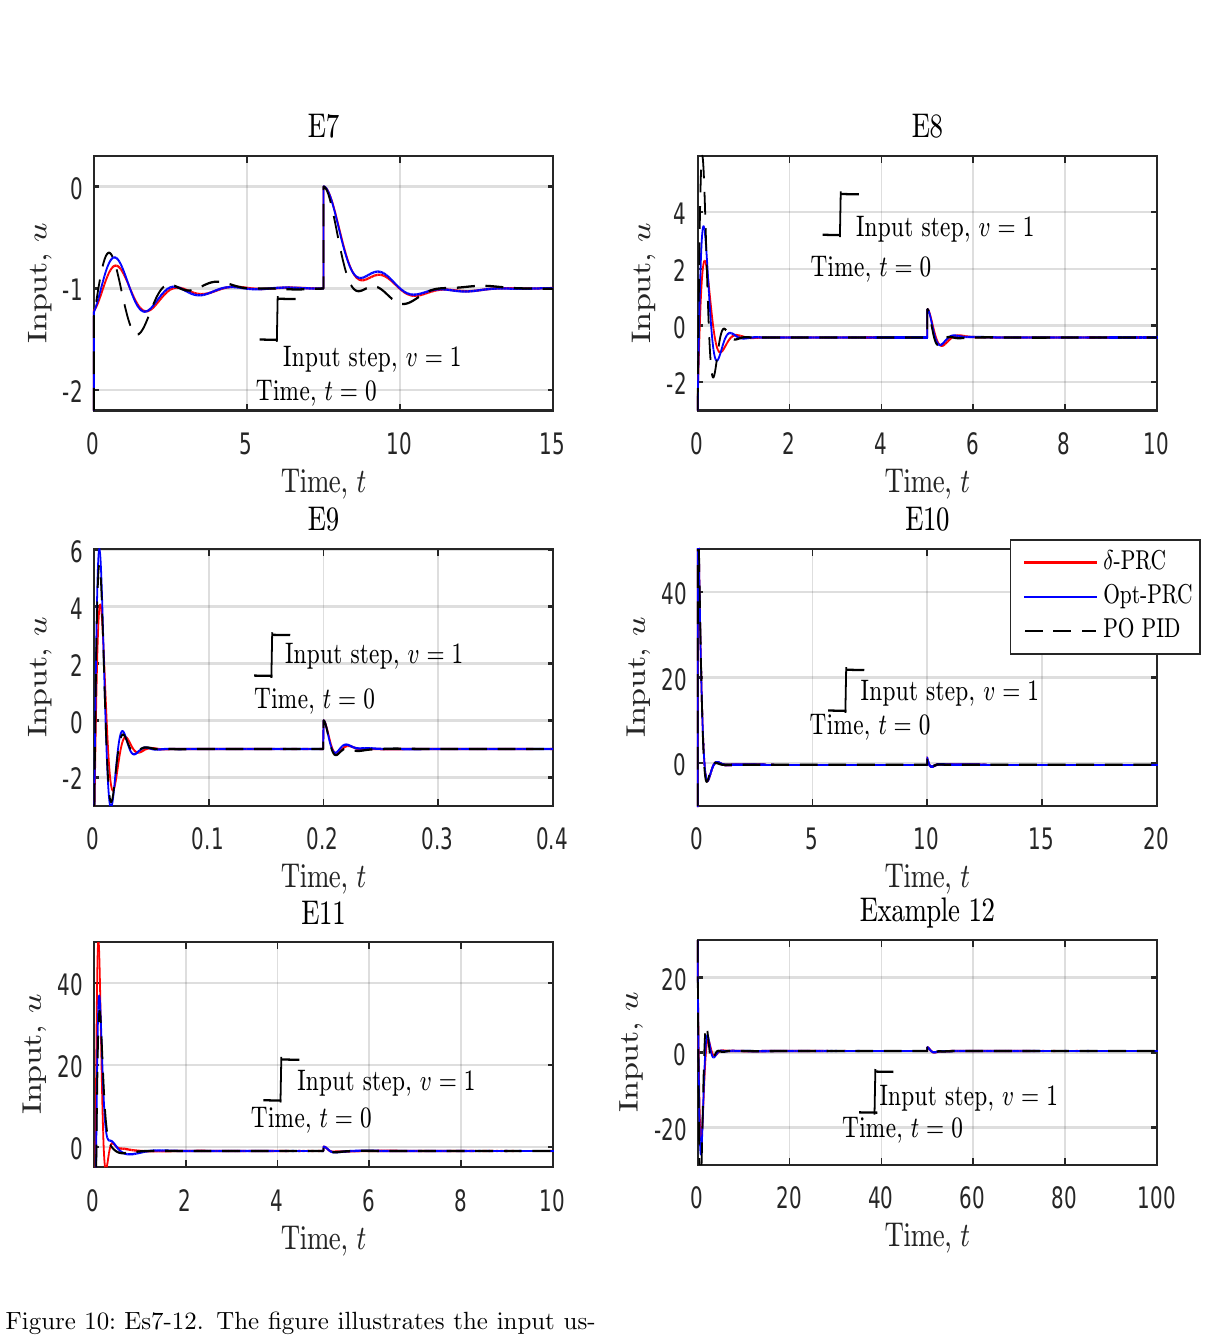
Figure 10: Es7-12. The figure illustrates the input us- age for a prescribed robustness, M s = 1 . 59, for the following methods: δ -PRC, SIMC, K-SIMC and PO